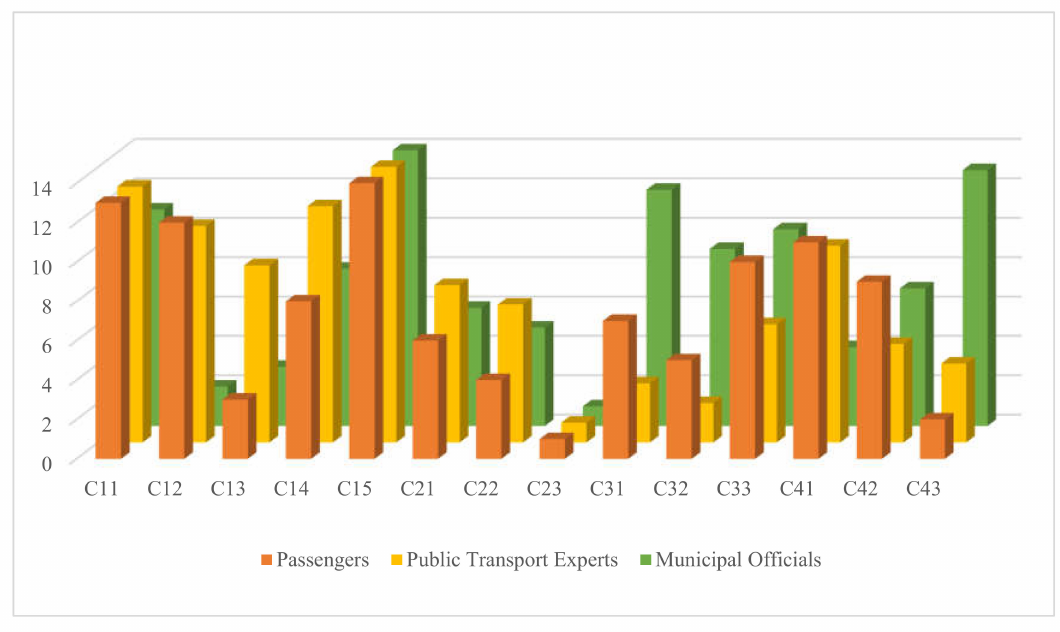
Figure 4. The subfactors rank based on the di ff erent group preferences on the second level.